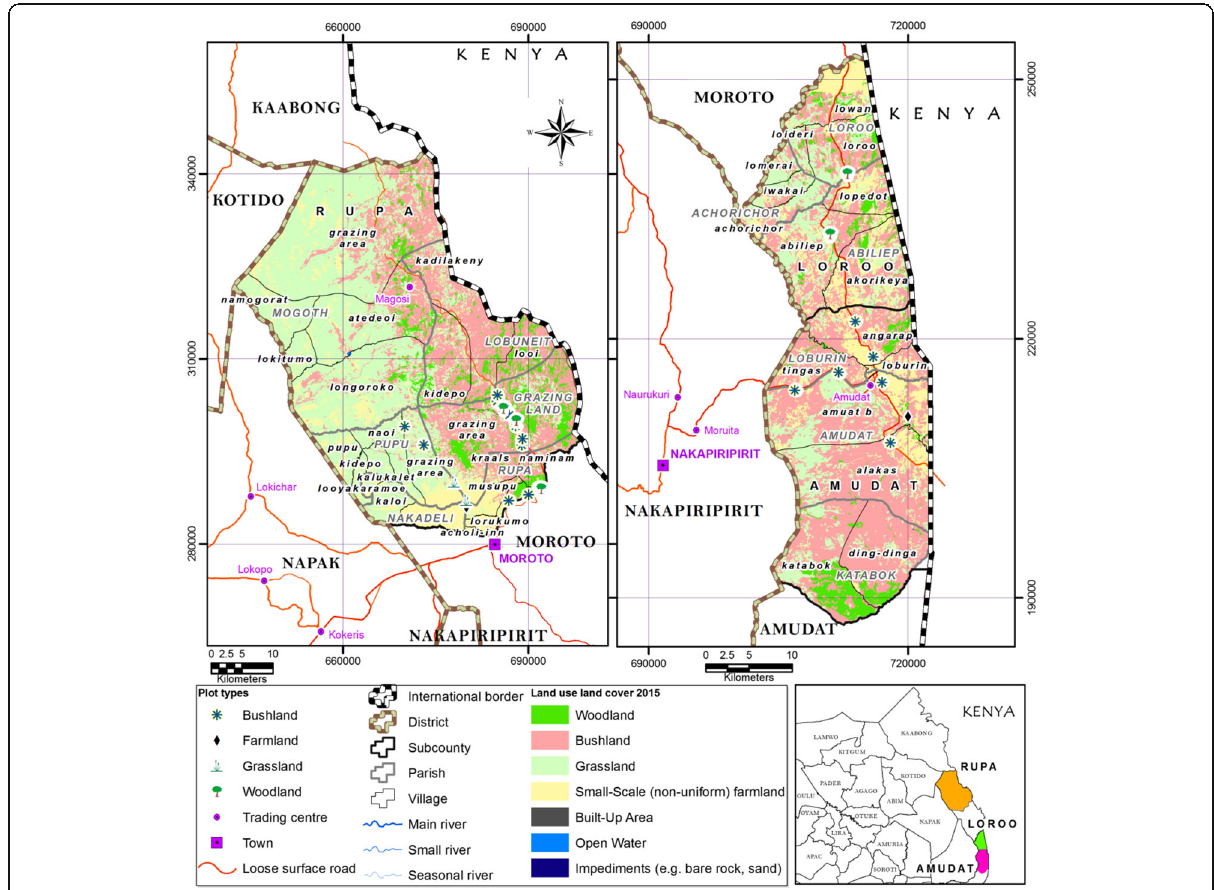
Figure 1 Map showing sampling points in Moroto district ( left ) and Amudat district ( right